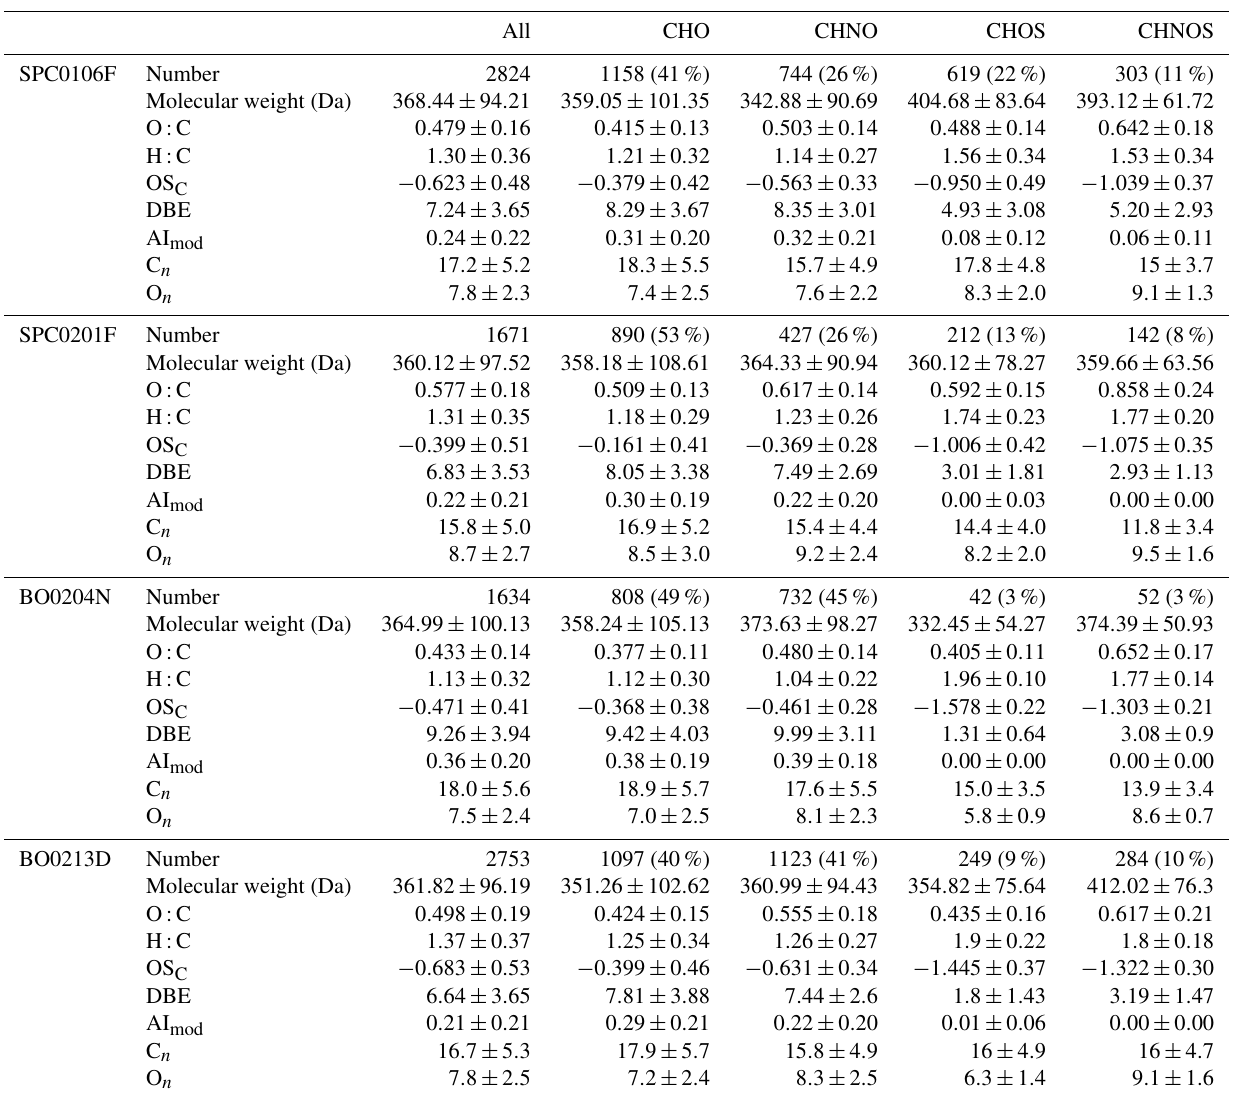
Table 2. Summary of FT-ICR MS formula assignment data. Mass, O:C, H:C, OS C , DBE, AI, C n , and O n values represent mathematical averages based on formula assignment, with standard deviation provided. These values were obtained using Eqs.